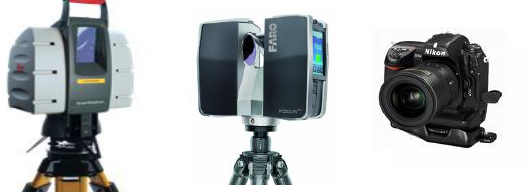
Figure 1. The employed sensors. From the left, Leica Scan Station HDS 3000, Faro Laser Scanner Focus 3D and NIKON D2X digital